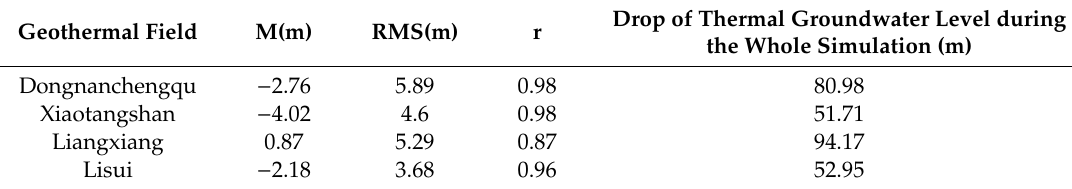
Figure 15. Distribution of hydraulic heads of groundwater at the end of the simulated period.